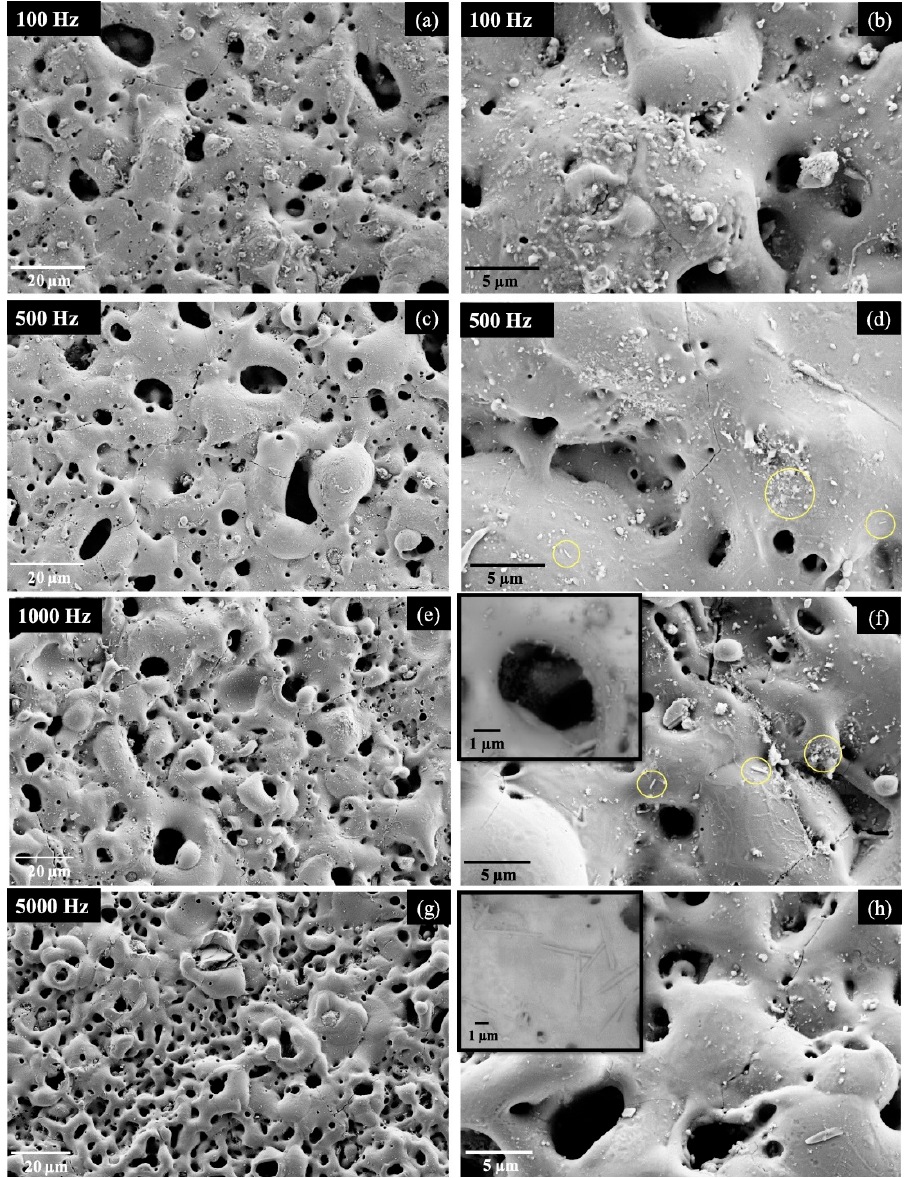
Figure 9. SEM micrographs of HNT-containing PEO coatings produced at ( a , b ) 100 Hz, ( c , d ) 500 Hz ( e , f ) 1000 Hz and ( g , h ) 5000 Hz frequencies. Yellow circles indicate remaining HNTS [88].